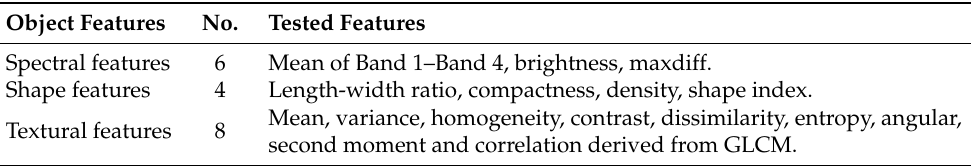
Table 1. Overview of extracted features for OBCD using HR